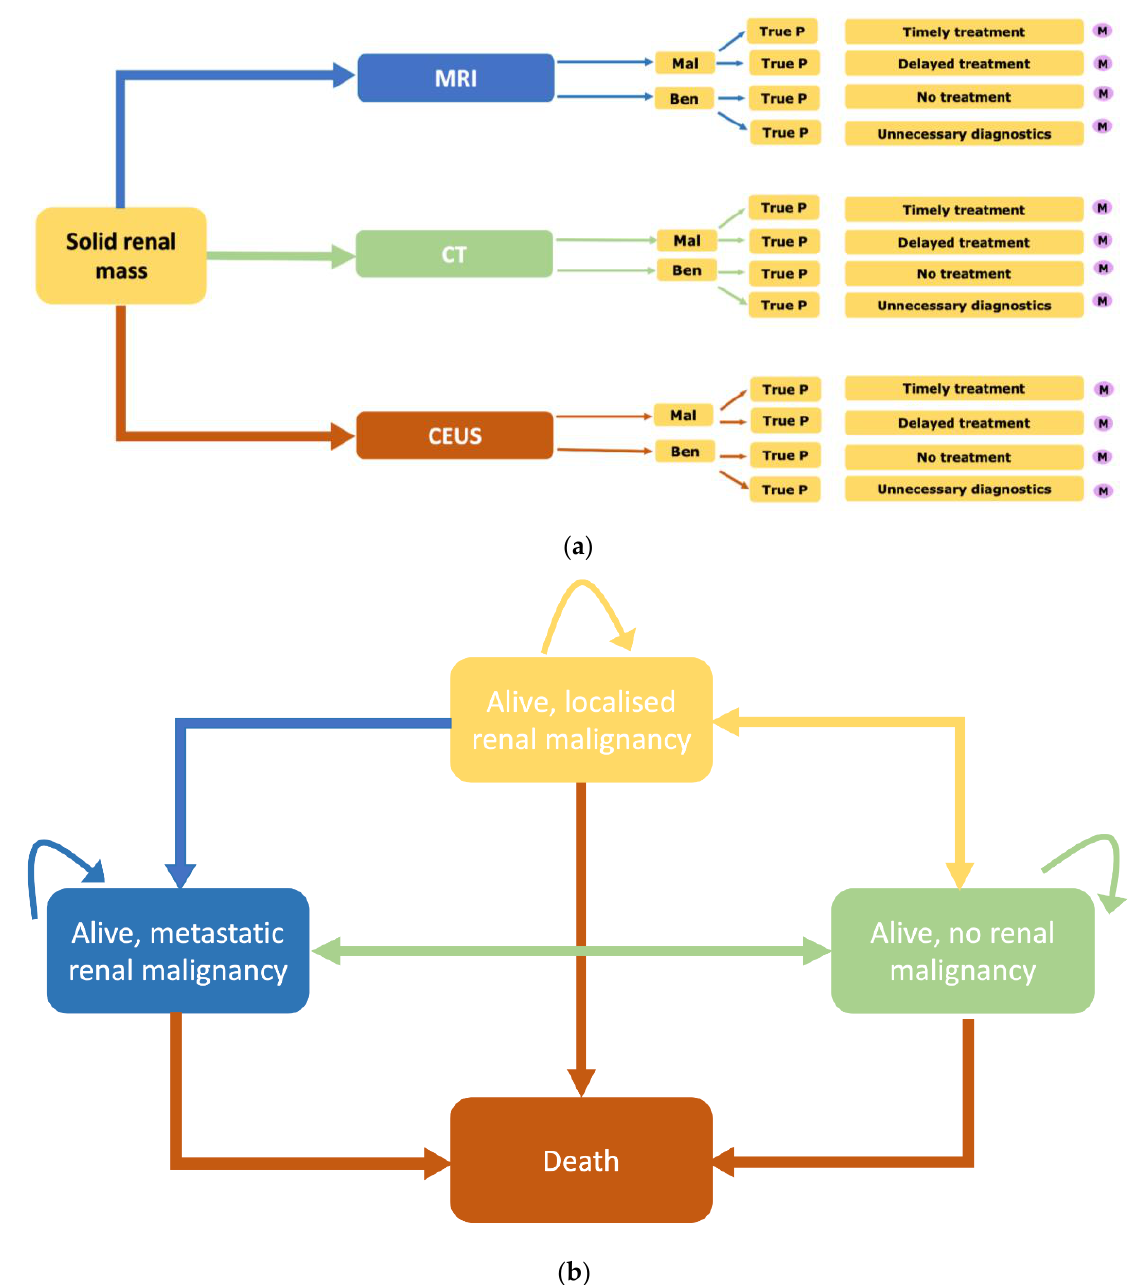
Figure 5. Markov layout. ( a ) A decision matrix for every strategy integrating CEUS, MRI and CT. For every result, a Markov calculation was executed. ( b ) Markov model for solid renal masses with potential stages “Alive, metastatic renal malignancy”, “Alive, localized renal malignancy”, “Alive, no renal malignancy” and “death”. The starting stage was specified dependent on the results in the decision model.